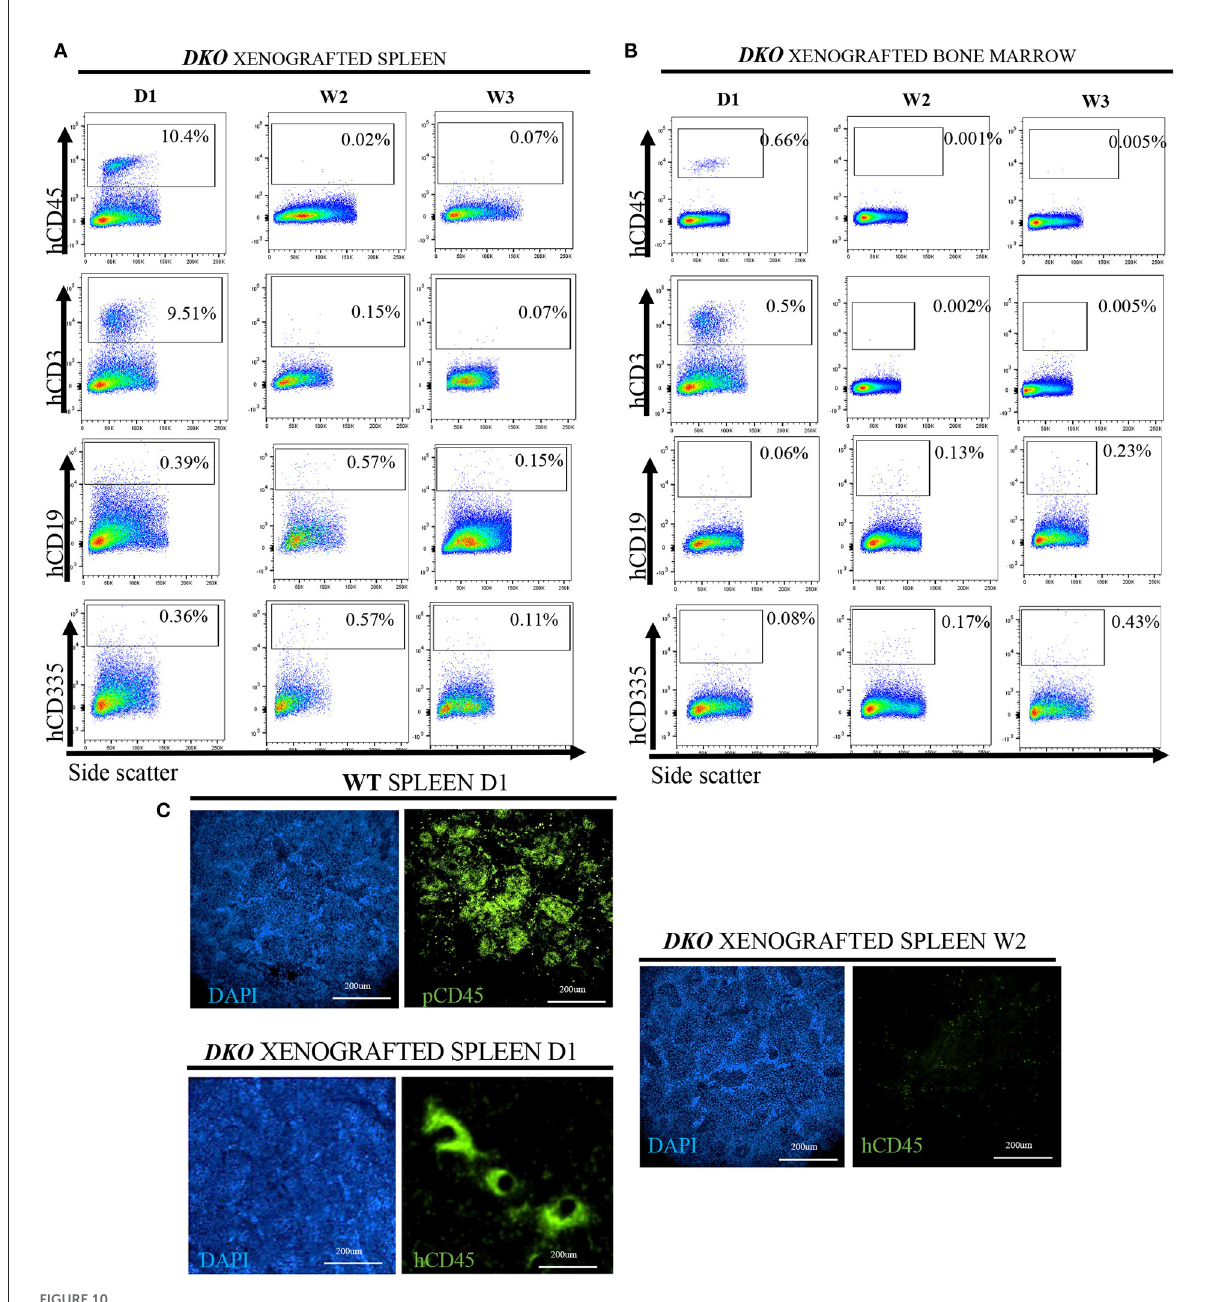
FIGURE10 Postnatal clearance of human cells from the spleen and bone marrow of xenografted DKO pigs. Flow cytometry analysis for the presence of human CD45 + , human CD3 + , human CD19 + and human CD335 (versus side scatter) in the spleen (A) or bone marrow (B) of xenografted DKO pigs from birth to 3 weeks of age. Human CD45 + and human CD3 + cells were identified in the bone marrow and spleen of a DKO pig at birth but became undetectable between 2 and 3 weeks of age. Few, if any, hCD19 or hCD335 were detected at any stage of analysis. These data parallels that seen in circulating cells. (C) Detection and the overall organization of CD45 + cells in the spleen (20x magnification) of WT (pCD45) ( n = 1) and xenografted DKO (hCD45) ( n = 1) at day 1, and week 2 ( n = 1). Human CD45 + cells were detected at day 1 but not at week 2 in DKO xenografted pigs, consistent with the clearance observed via flow cytometry. Immune-competent WT pig spleen staining with pig-specific CD45 antibodies showed multifocal distribution of pig CD45, as expected. In contrast, xenografted DKO day 1 spleen showed a different pattern, with human CD45 cells surrounding areas that resemble large vascular